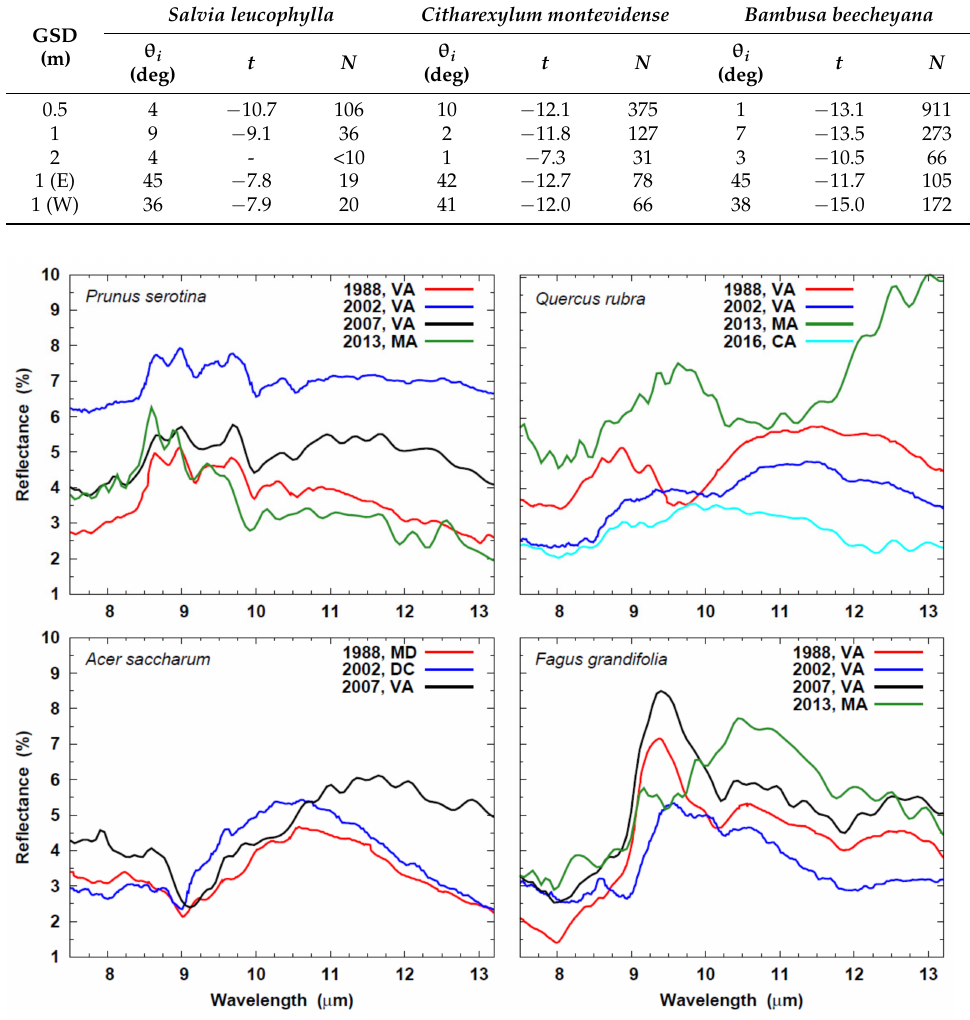
Figure 7. Geographical and temporal variability of LWIR foliar reflectance spectra for four unrelated arboreal species: ( top left ) Prunus serotina , ( top right ) Quercus rubra , ( lower left ) Acer saccharum , ( lower right ) Fagus grandifolia